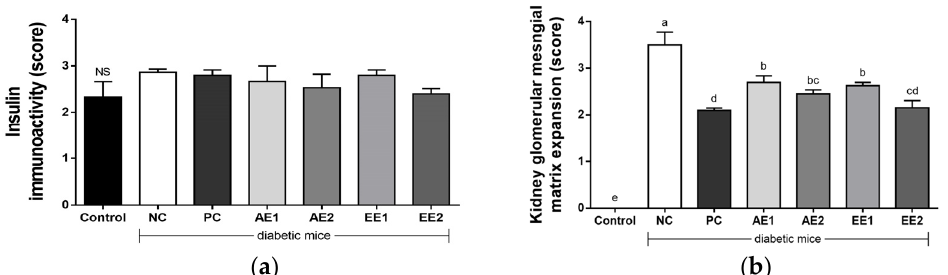
Figure 8. Effects of A. hookeri extracts on ( a ) insulin immunoactivity score in the pancreas and on ( b ) glomerular mesangial expansion score in the kidney of the diabetic mice. Control: non-diabetic mice; NC: negative control; PC: positive control; AE1: aqueous extract 100 mg/kg BW; AE2: aqueous extract 200 mg/kg BW; EE1: ethanol extract 100 mg/kg BW; EE2: ethanol extract 200 mg/kg BW. AE and EE groups were treated with Allium hookeri extracts for 8 weeks. Data are presented as the mean ± SEM (n = 8). NS Not significantly different among groups. a–e Different letters mean values are considered statistically significant at p < 0.05.